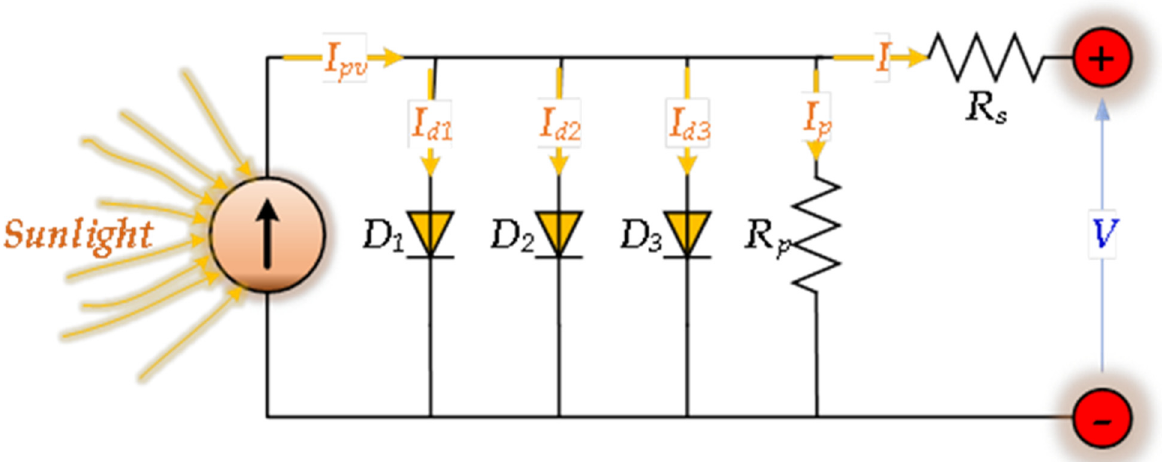
Figure 2. TDM of a solar